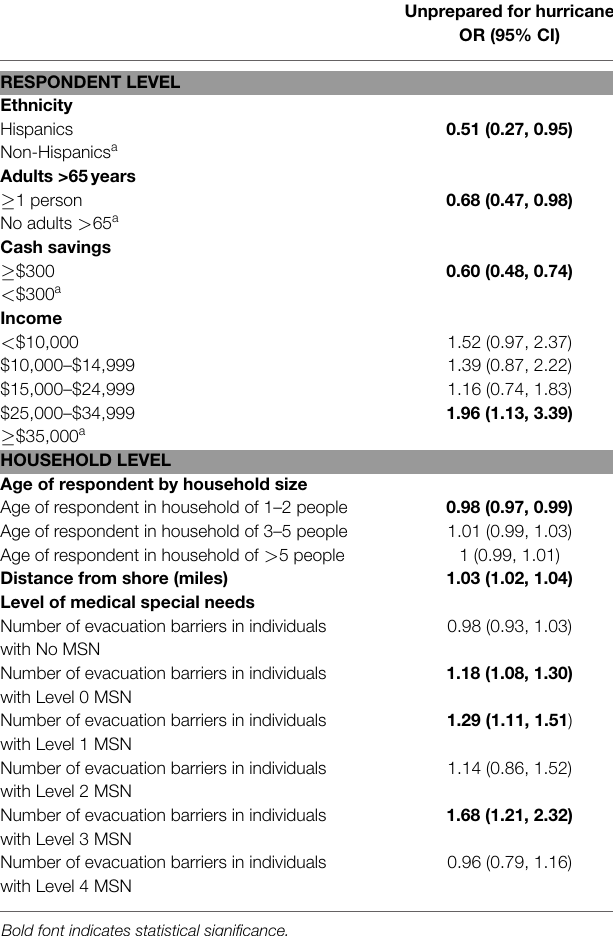
TABLE 5 | Multivariable logistic regression model for probability of being unprepared for effects